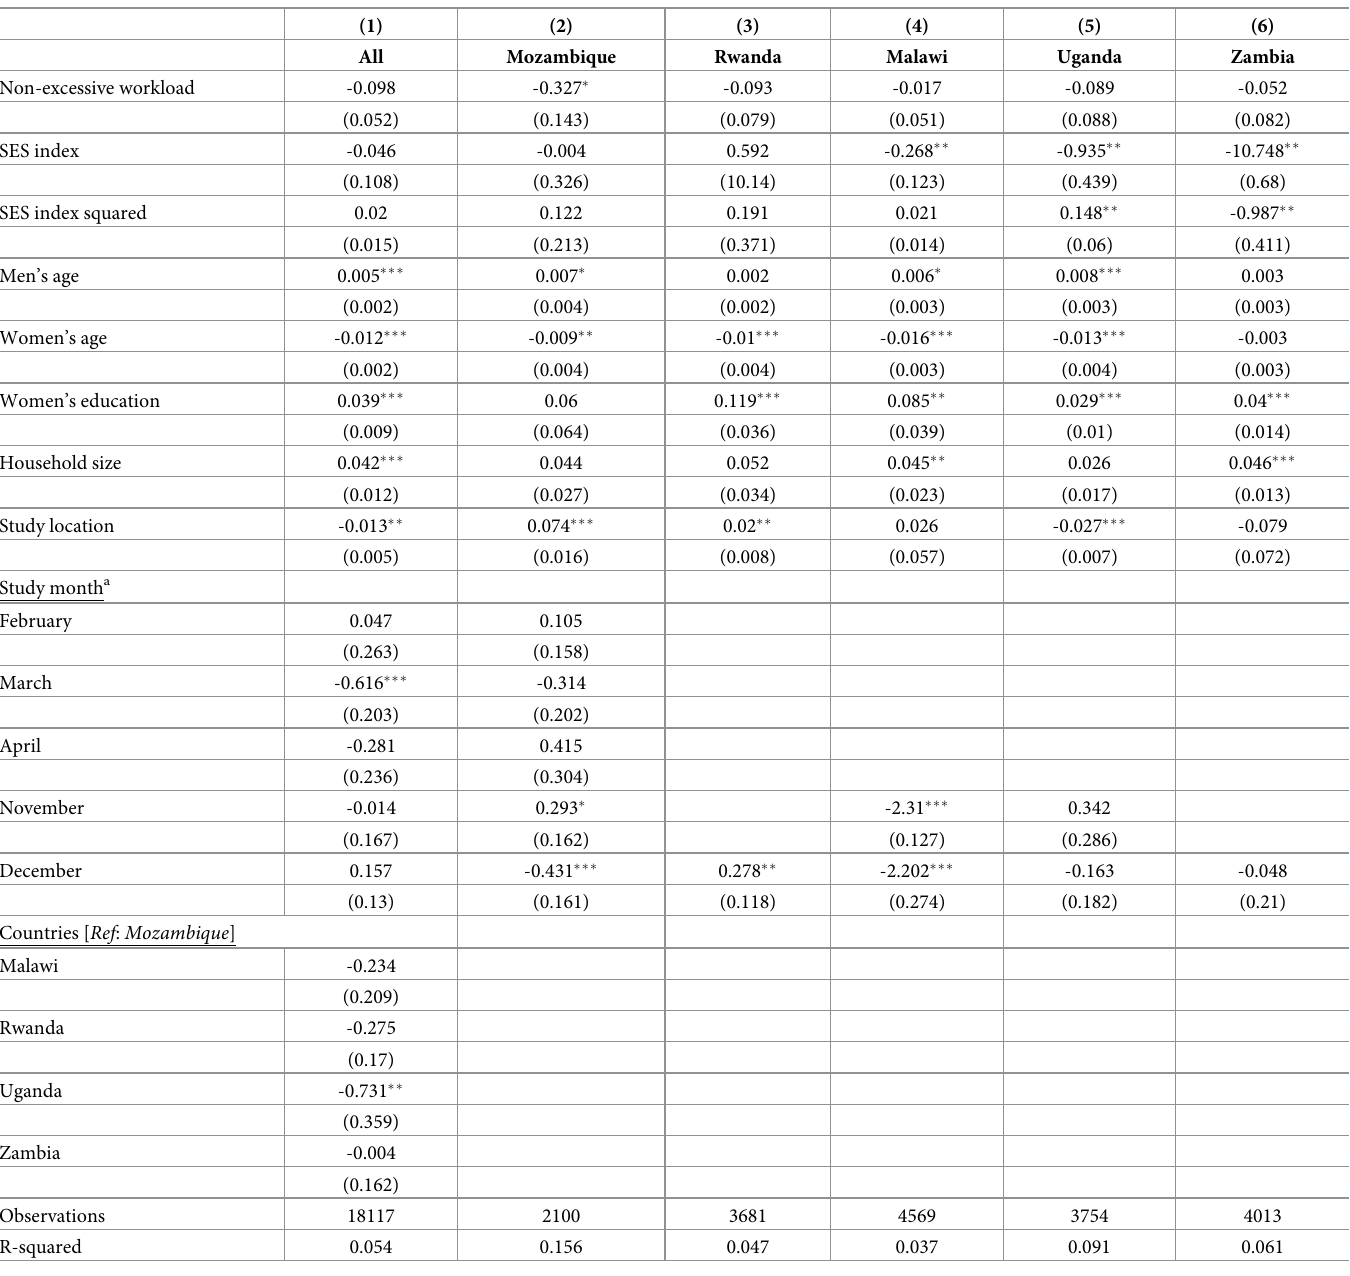
Table 13. OLS regression for WDDS–time domain (Non-excessive workload [ < 10.5hrs in